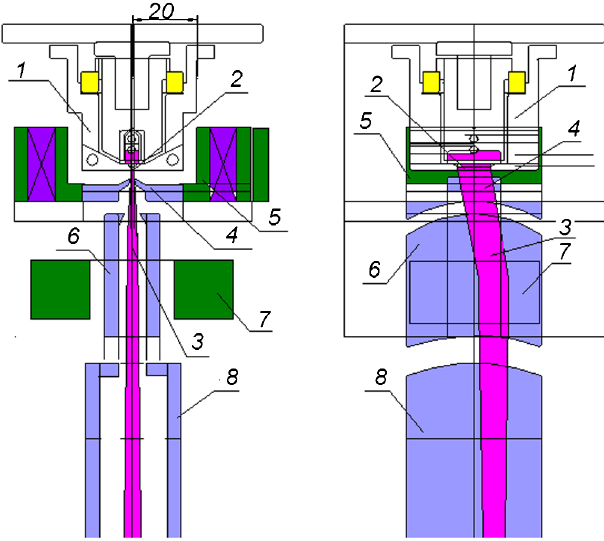
FIG. 6. PD SPS with transaxial lens focusing (left—cross section along magnetic field; right—cross section perpendicular to magnetic field). (1) PD SPS; (2) emission slit; (3) ion beam; (4) extraction electrode; (5) magnet of SPS; (6) grounded elec- trode of transaxial immersion lens; (7) compensating magnet; (8) first transaxial